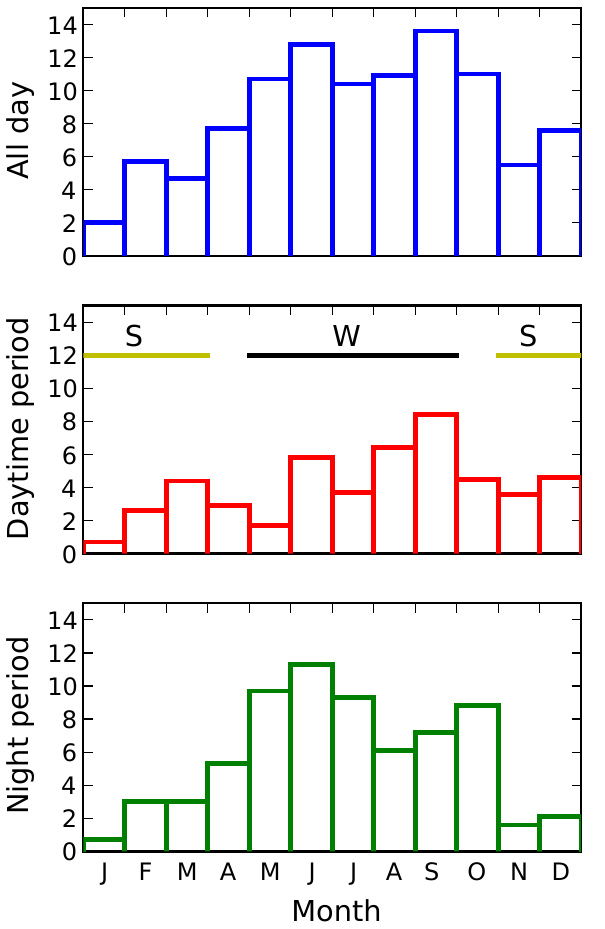
Figure 2(a): Seasonal incidence Fig 2(b): Incidence/Ap